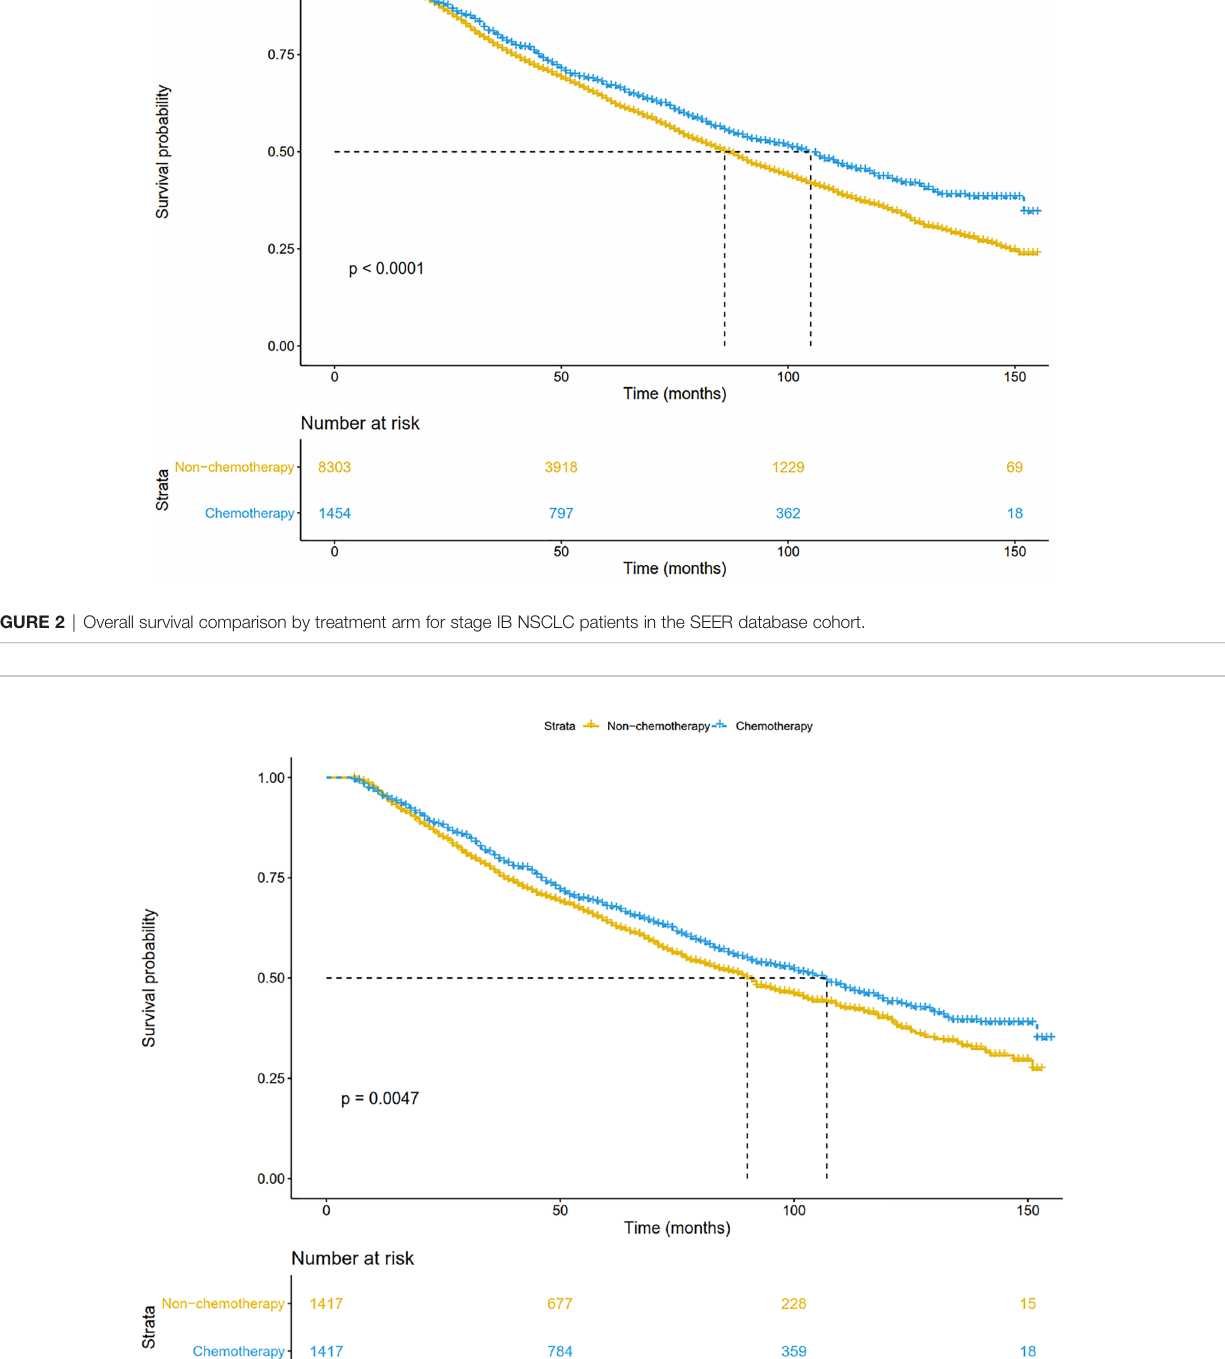
Frontiers in Oncology |